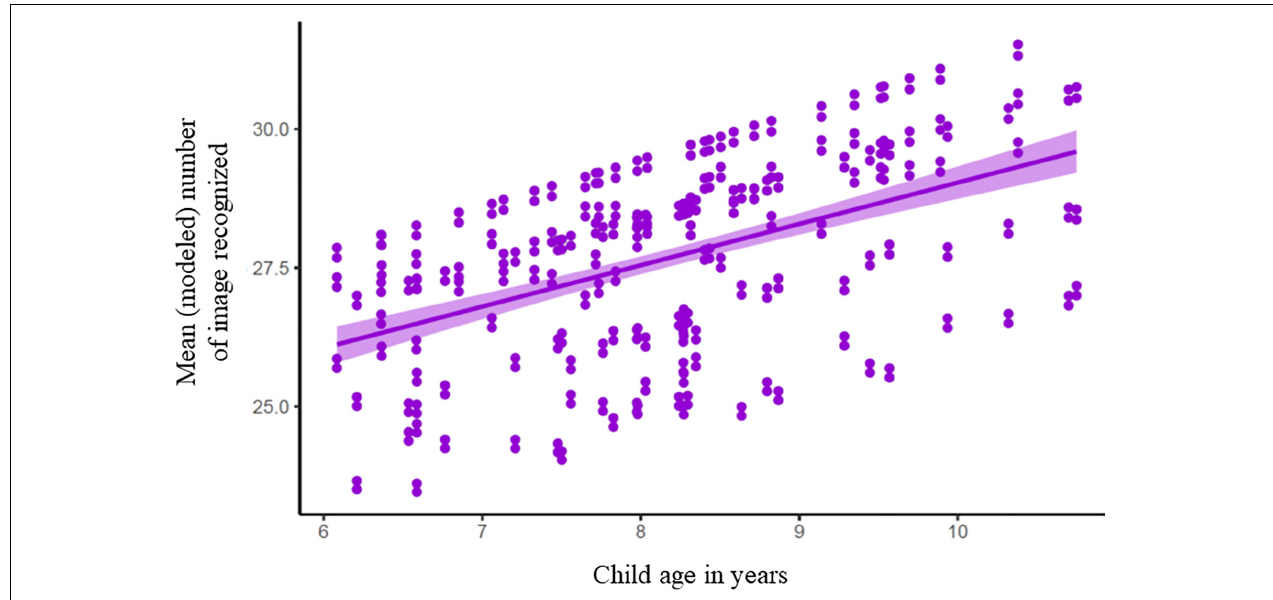
FIGURE 3 | Accuracy of recognition of images. depicting high-ED. low-ED. and office supplies. increased with child age [ P = 0.001; F (155) = 11.52. Cohen’s d = 0.44] and recognition increased by 2.7% (SE = 0.78) for each year increase in age in a sample of children ranging froni 6.08 to 10.75 years of age. Modeled slope and standard errors along with individual data points are values extracted from the